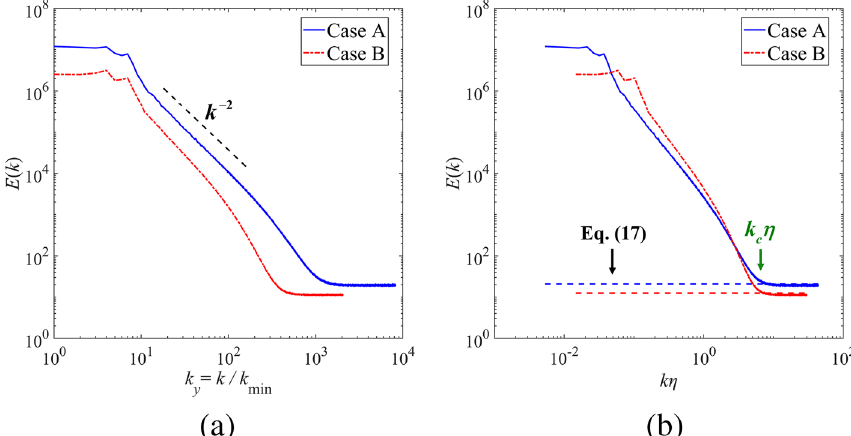
Fig. 3 The energy spectra of 1D compressible turbulence in the A and B cases. The abscissa of panel (a) is the wavenumber index, and the abscissa of panel (b) is the wavenumber multiplied by the Kolmogorov length scale. The spectra of thermal fluctuations calculated from Eq. (17) are also shown in panel (b) for